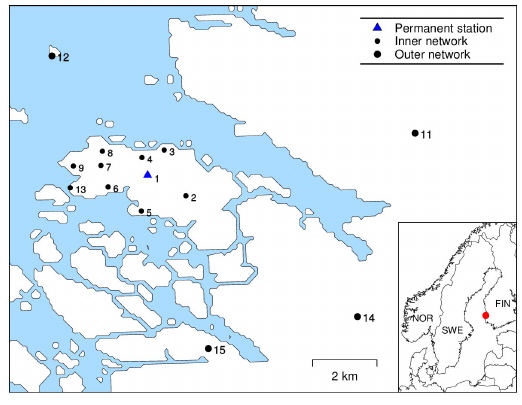
Figure 1. GPS observation sites at Olkiluoto.